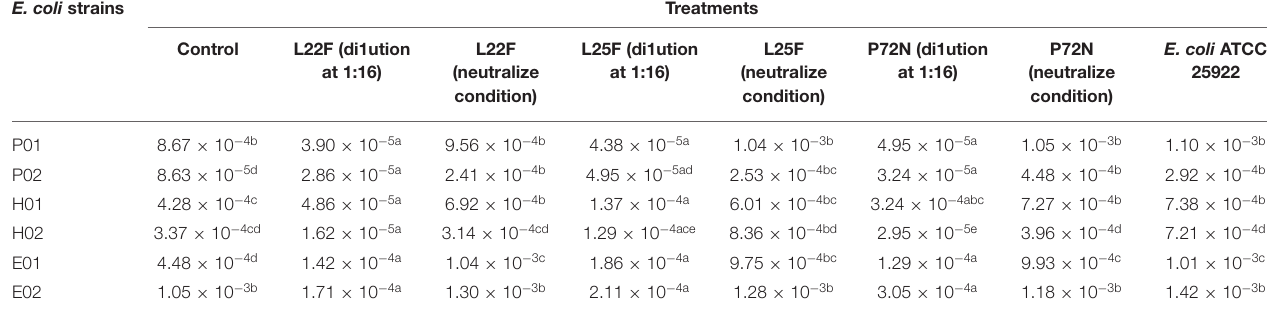
TABLE 2 | Effects of CFS of LAB on transfer